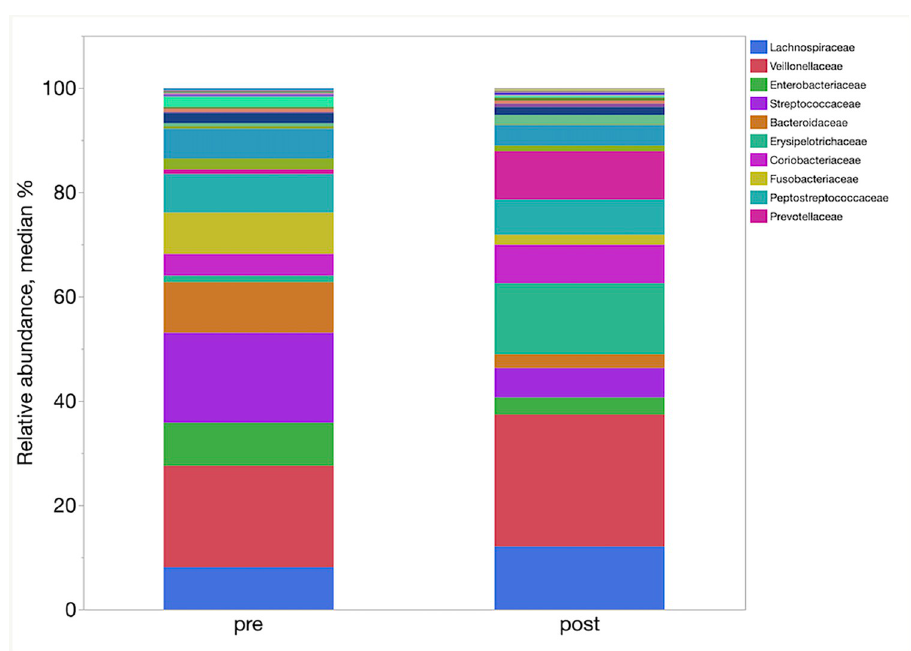
Fig 7. Relative abundances of the main bacterial families enriched between the pre and one-week post FMT samples.